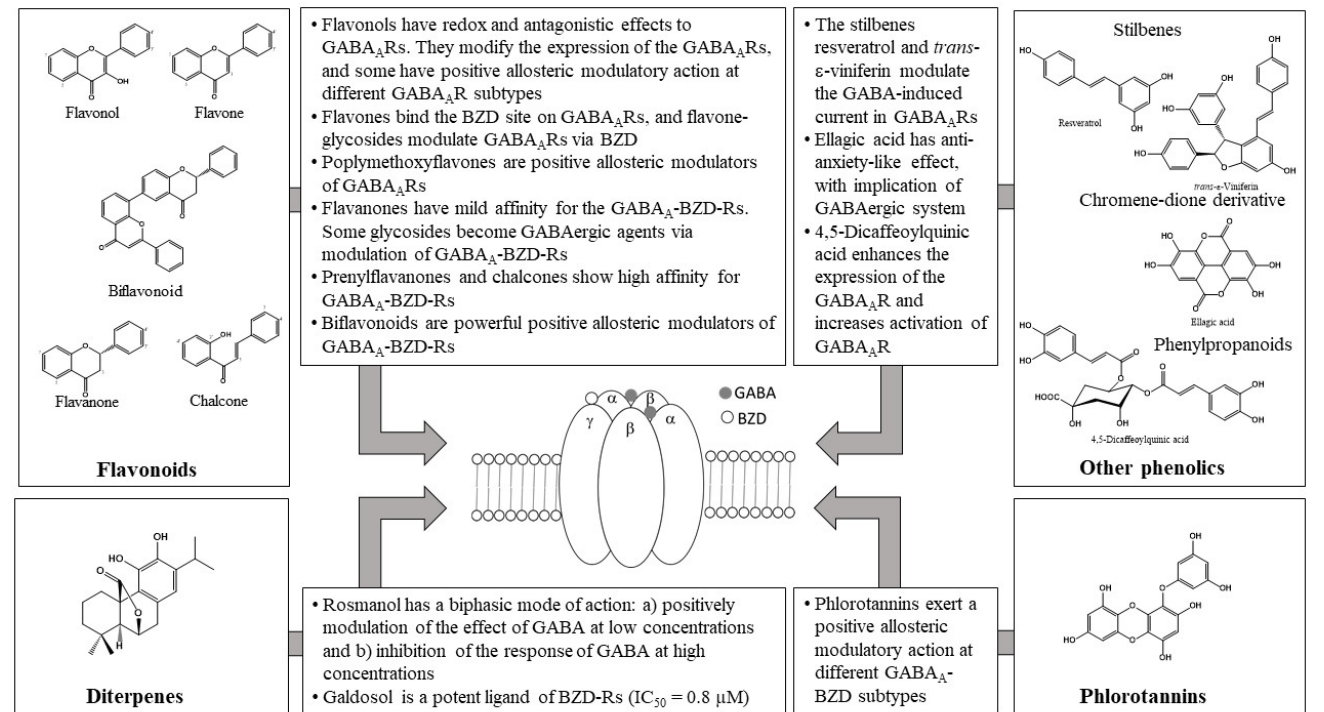
Figure 6. Scheme summarizing the main GABAergic effects of phenolics.